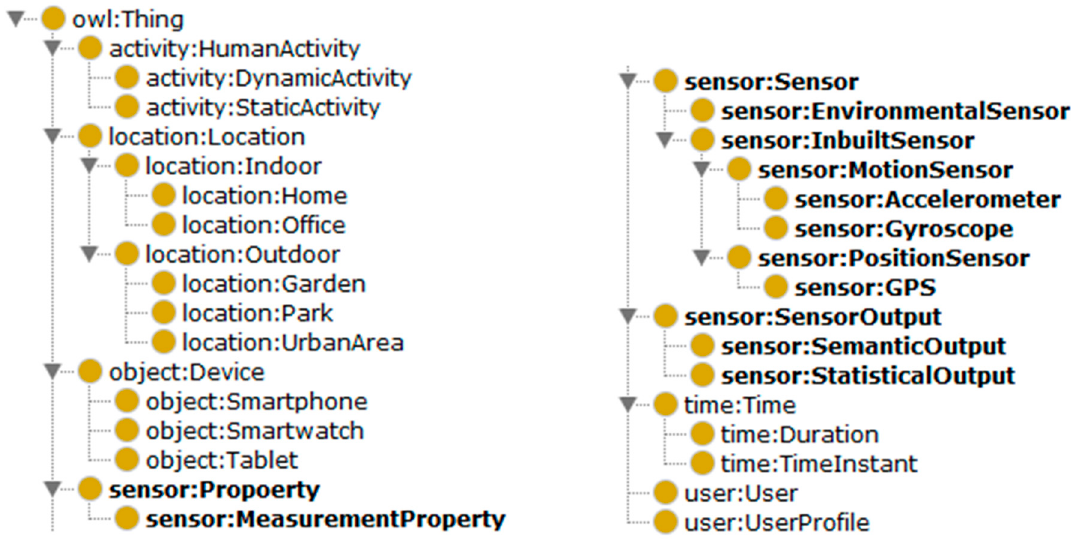
Figure 7. MAROlogy implemented with